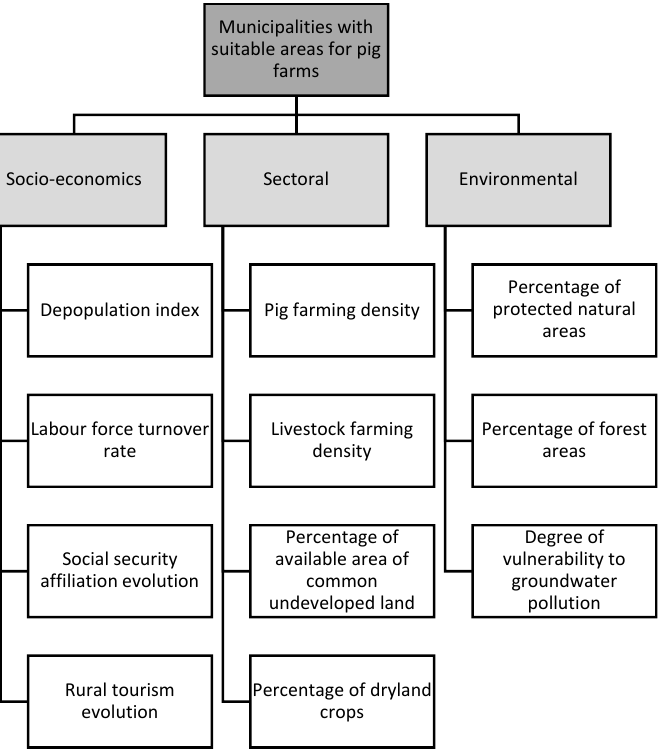
Figure 6. Hierarchy of criteria for evaluation of municipalities with suitable livestock area.